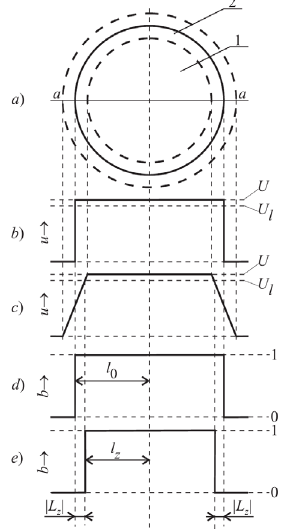
Fig. 1. A model of formation and transformation of the mark